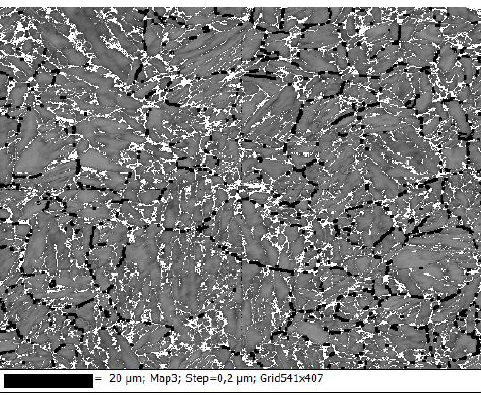
Figure 5. The martensite boundaries that are marked with black colour in the band contrast image represents parent austenite boundaries. ( a – c ) show misorientations between 15°–48°; ( d – f ) show the Kurdjumov-Sachs orientation relationship (±10°).